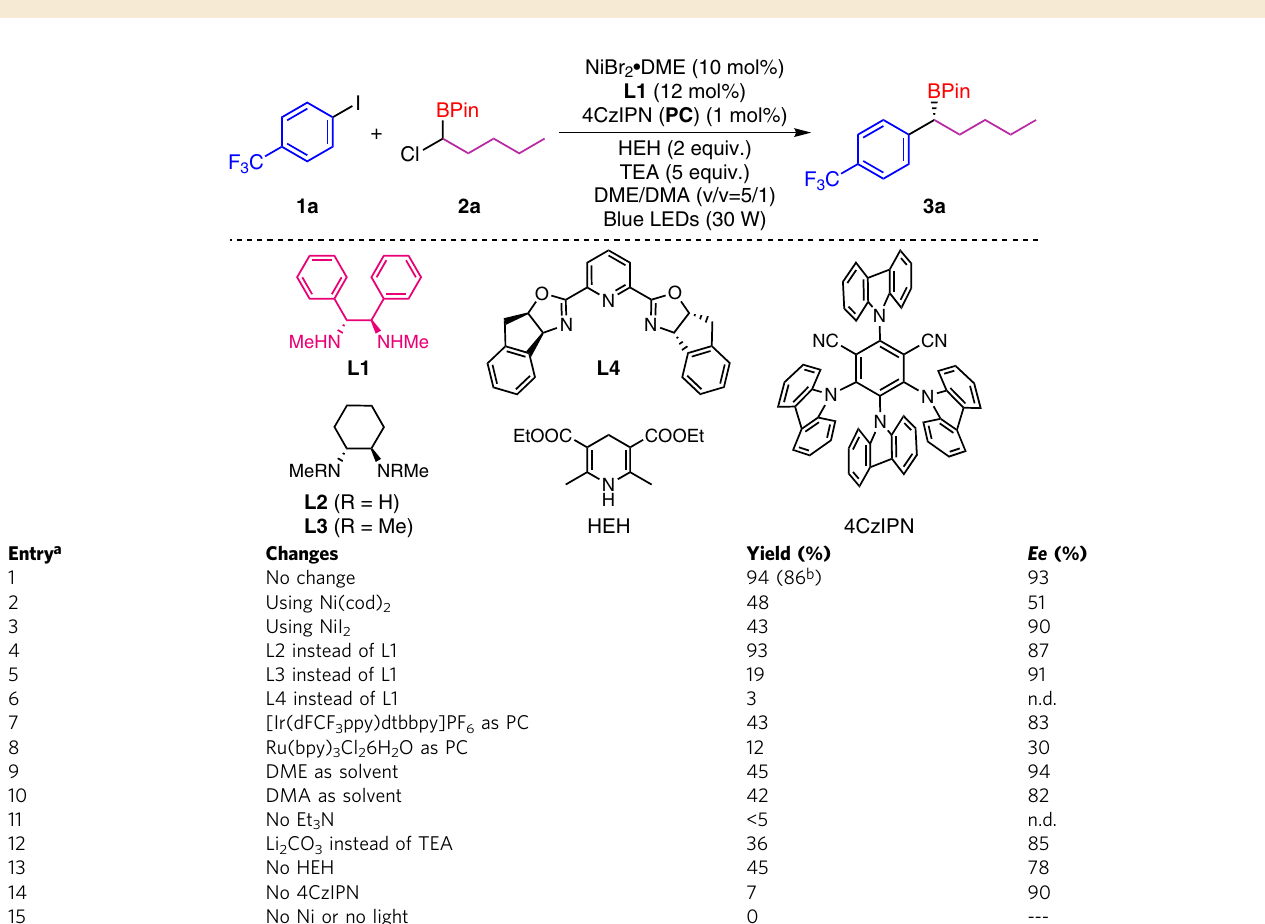
Table 1 Optimization of reaction conditions.